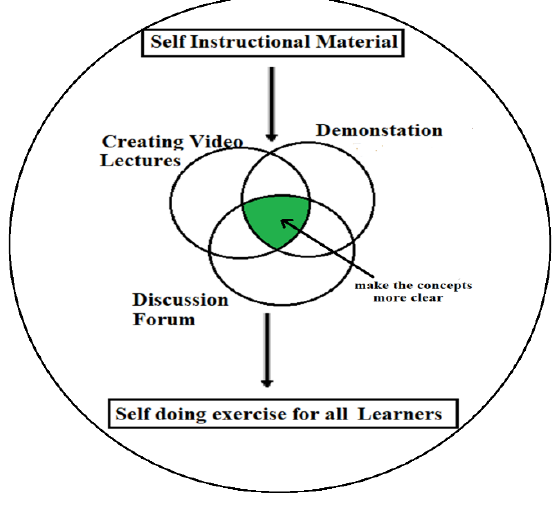
Algorithm 2: OBE through Teaching Learning Process in online platform.